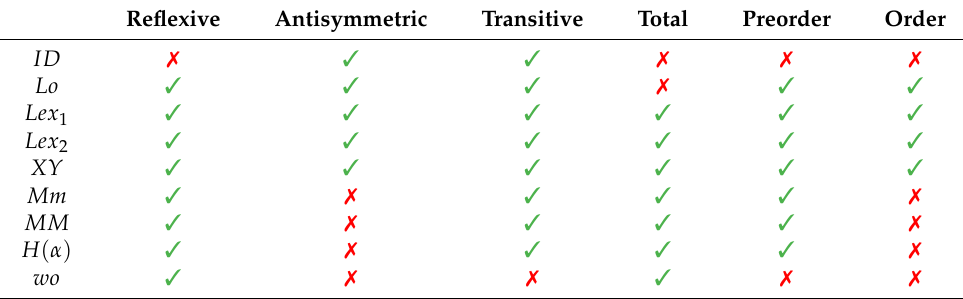
Table 1. Some properties of the considered relations on L ([ 0,1 ])